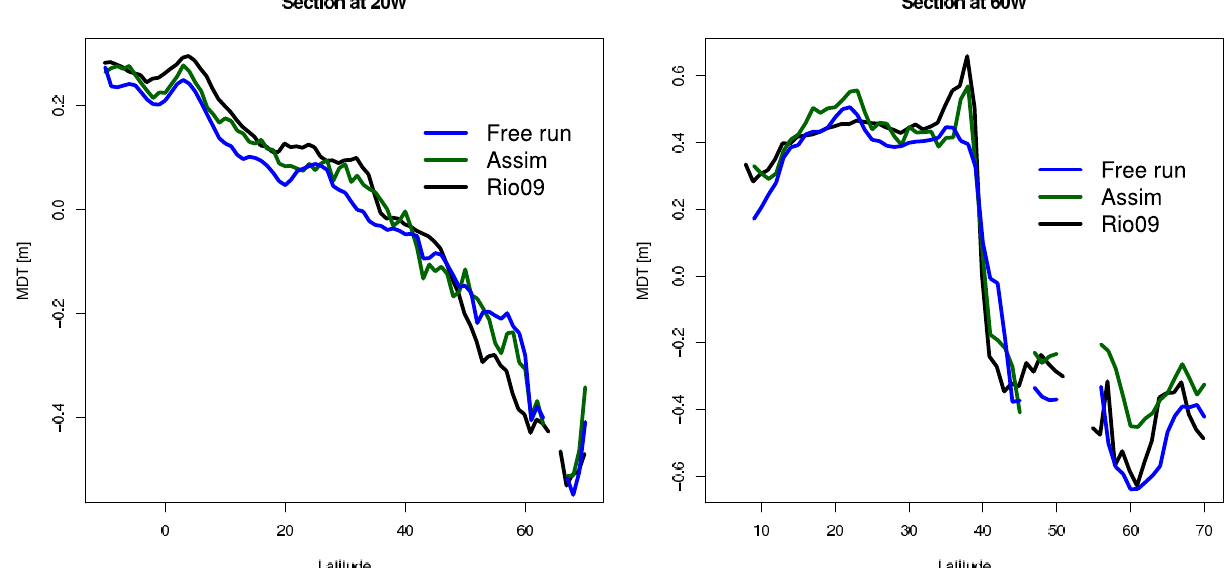
Fig. 9. Sections of MDT from Rio09 (black), HYCOM free run (blue), and estimated with data assimilation (green). An offset of 15cm has been removed from the Rio09 data.